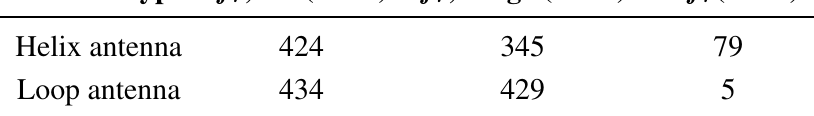
Table 1. Resonance frequency of the antennas in both air and silage. The helix antenna is significantly more affected by the silage than the loop antenna.